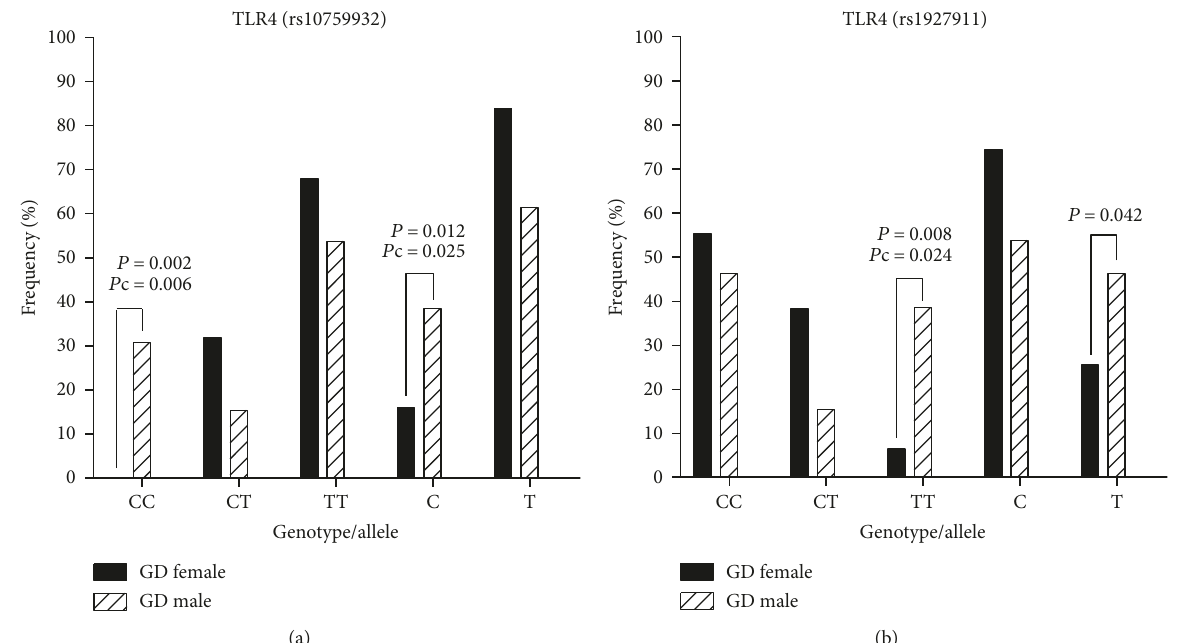
Figure 1: Analysis of TLR 4 gene polymorphism between female and male in Graves ’ disease (GD); the frequency of the TLR4 rs10759932 CC genotype (OR=24; 95% CI, 2.52 – 228.3, P = 0 002 , P c = 0 006 ), C allele (OR =3.29; 95% CI, 1.26 – 8.63, P = 0 012 , P c = 0 025 ), and TLR4 rs1927911 TT genotype (OR =9.17; 95% CI, 1.82 – 46.20, P = 0 008 , P c = 0 024 ); and T allele (OR =2.5; 95% CI, 1.02 – 6.15, P = 0 042 ) in GD female was lower than that in GD